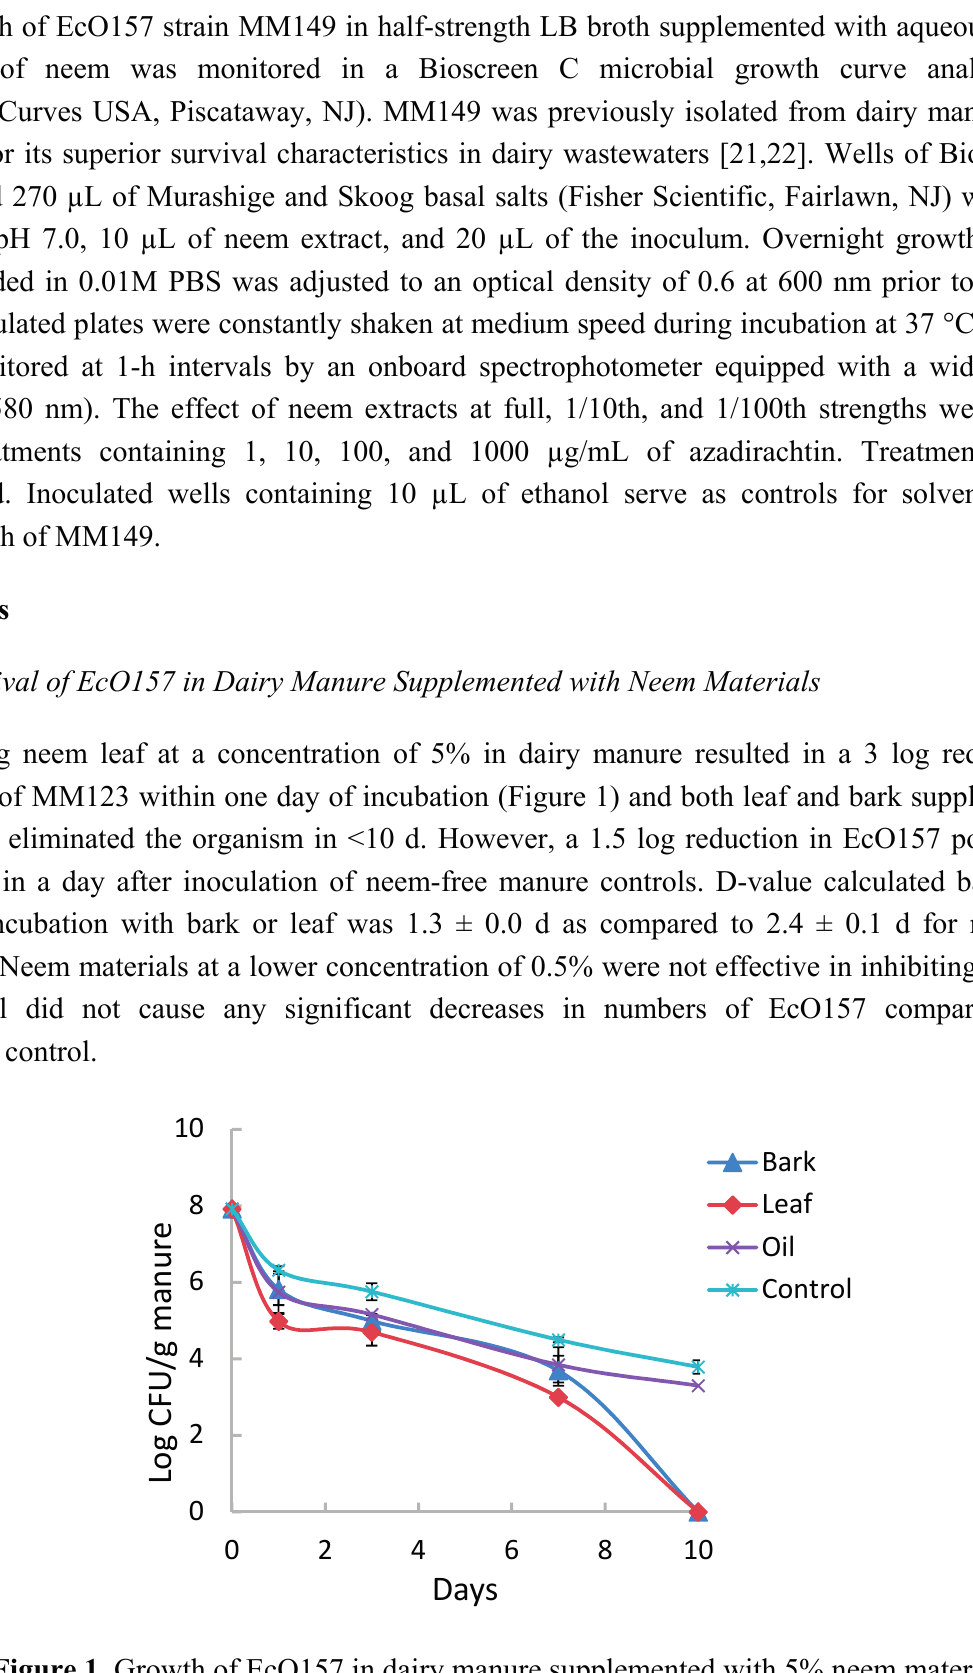
Figure 1. Growth of EcO157 in dairy manure supplemented with 5% neem